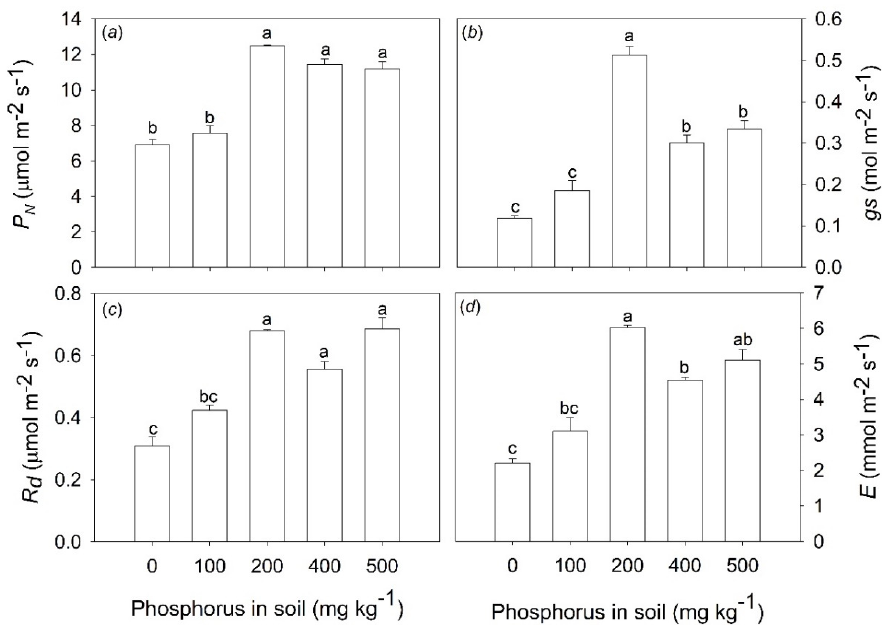
Figure 3. Net photosynthesis ( a ), stomatal conductance ( b ), dark respiration ( c ), and transpiration ( d ) of Bertholletia excelsa saplings under increasing doses of phosphorus in a P-deficient Amazon Ferralsol. Bars are the means and lines above the bars are the standard error. Different letters in the bars indicate significant differences between the means by the Tukey test at a 0.05 probability level. The P content in leaves and soil were positively correlated with light use efficiency (LUE), nitrogen (NUE), potassium (KUE), magnesium (MgUE), and manganese (MnUE) use efficiency by the B. excelsa saplings (Figure 4). Calcium use efficiency (CaUE) was cor- related with P contents in the leaf, but not with P soil (Figure 4). On the other hand, con- tents of P in leaves and soil were negatively correlated with water use efficiency (WUE), intrinsic water use efficiency (iWUE), P use efficiency (PUE), and zinc use efficiency (ZnUE) (Figure 4). No significant correlation was observed between the P contents in leaf or soil and iron use efficiency (FeUE) (Figure 4).